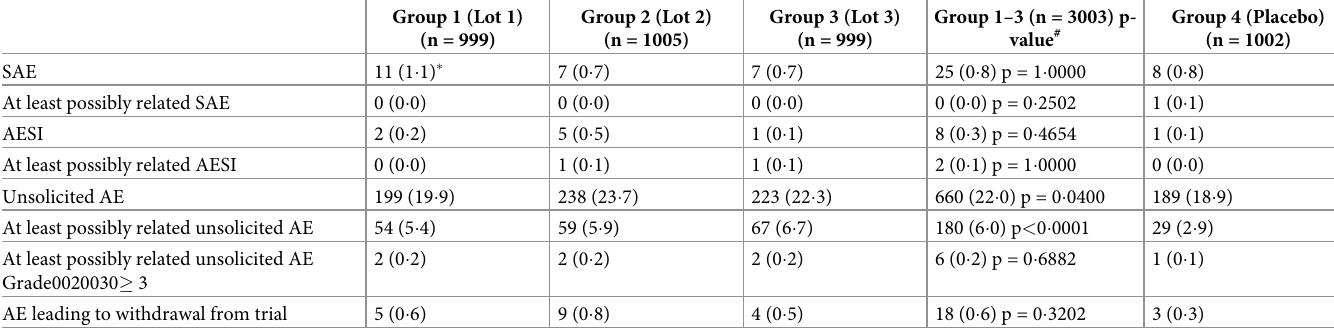
Table 2. Overview of unsolicited adverse events per subject (FAS, n =